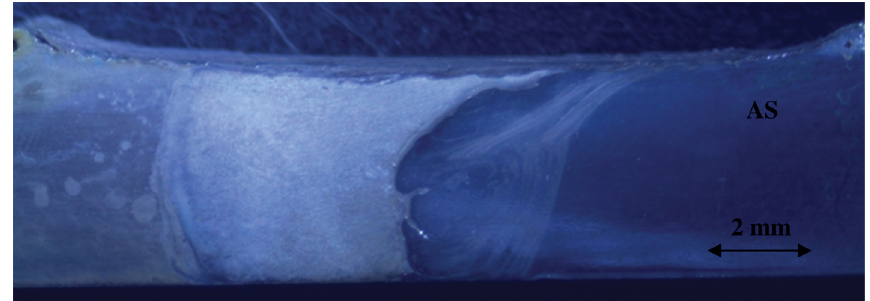
Figure 4: Cross-sectional macrostructure of the joint sample at zero interface offset, cut from the interface varied weld coupon shown in Figure 3.